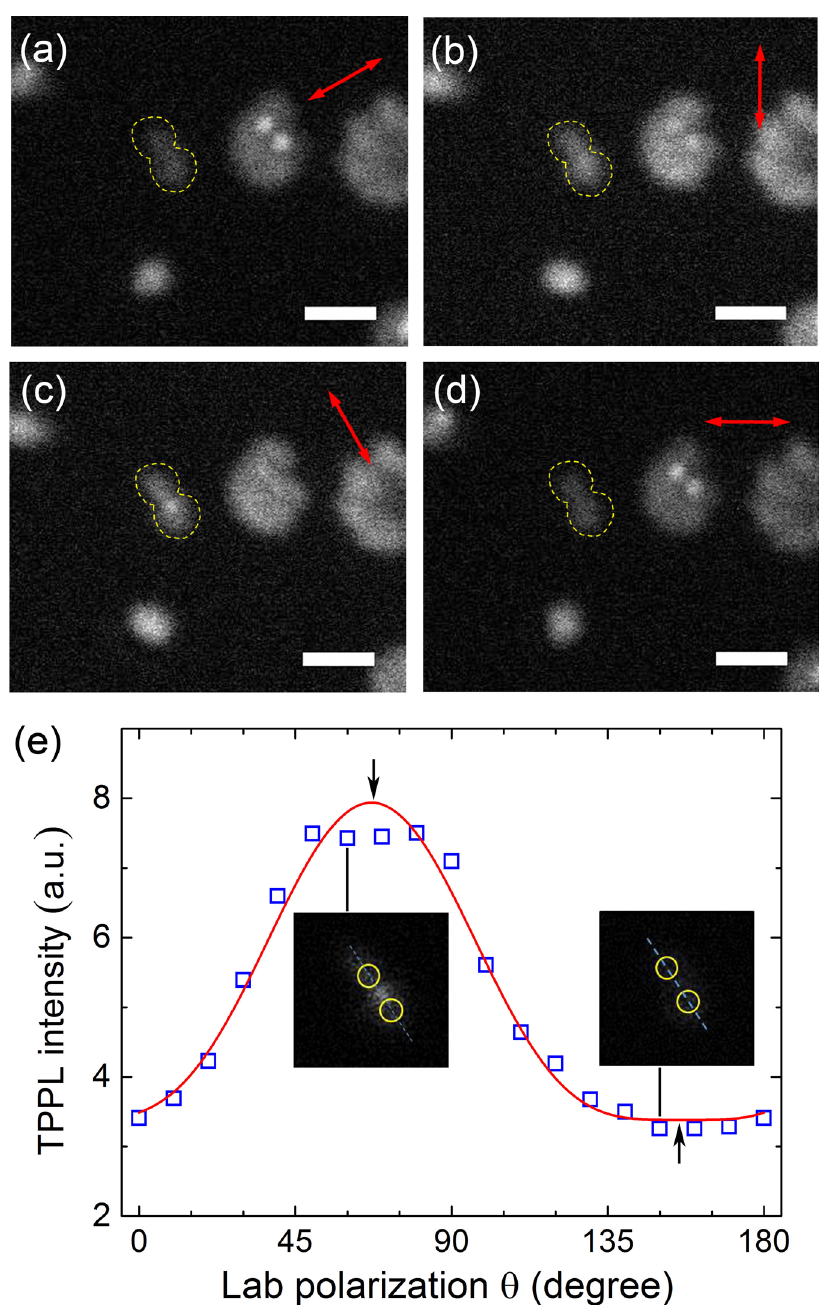
Figure 2. ( a – d ) TPPL images of the GNSs under BaTiO 3 microsphere with different incident polarisation directions (indicated by red arrows). Yellow dotted lines indicate the region where signal from a dimer structure is integrated. All scale bars: 500 nm. ( e ) Integrated TPPL intensity versus incident polarisation (open squares) together with a cos 4 θ curve fitting (solid line). Insets are images recorded at two polarisations close to the fitted maximum and minimum (black arrows). Yellow circles in the insets indicate the estimated topography of the GNS